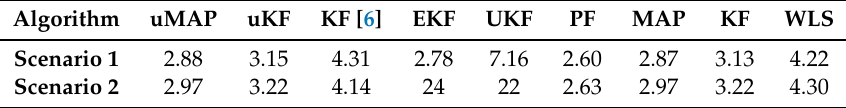
Table 2. RMSE (m) of the considered algorithms.